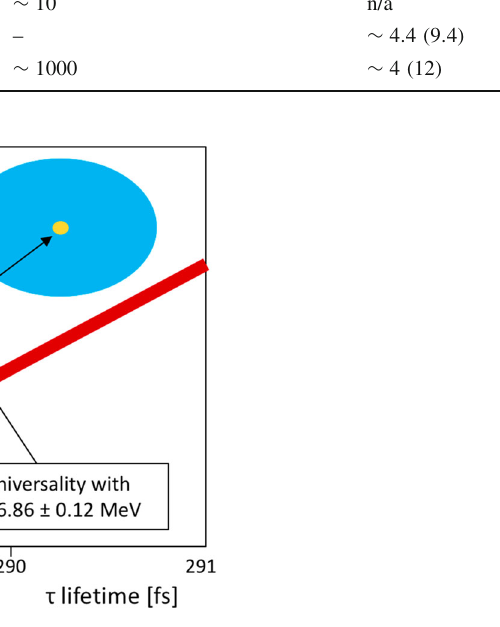
Fig. 7.2 Branching fraction of τ → e νν versus τ lifetime. The current world averages of the direct measurements are indicated with the blue ellipse. Suggested FCC-ee precisions are provided with the yellow ellipse. The SM functional dependence of the two quantities, depending on the τ mass, is displayed by the red